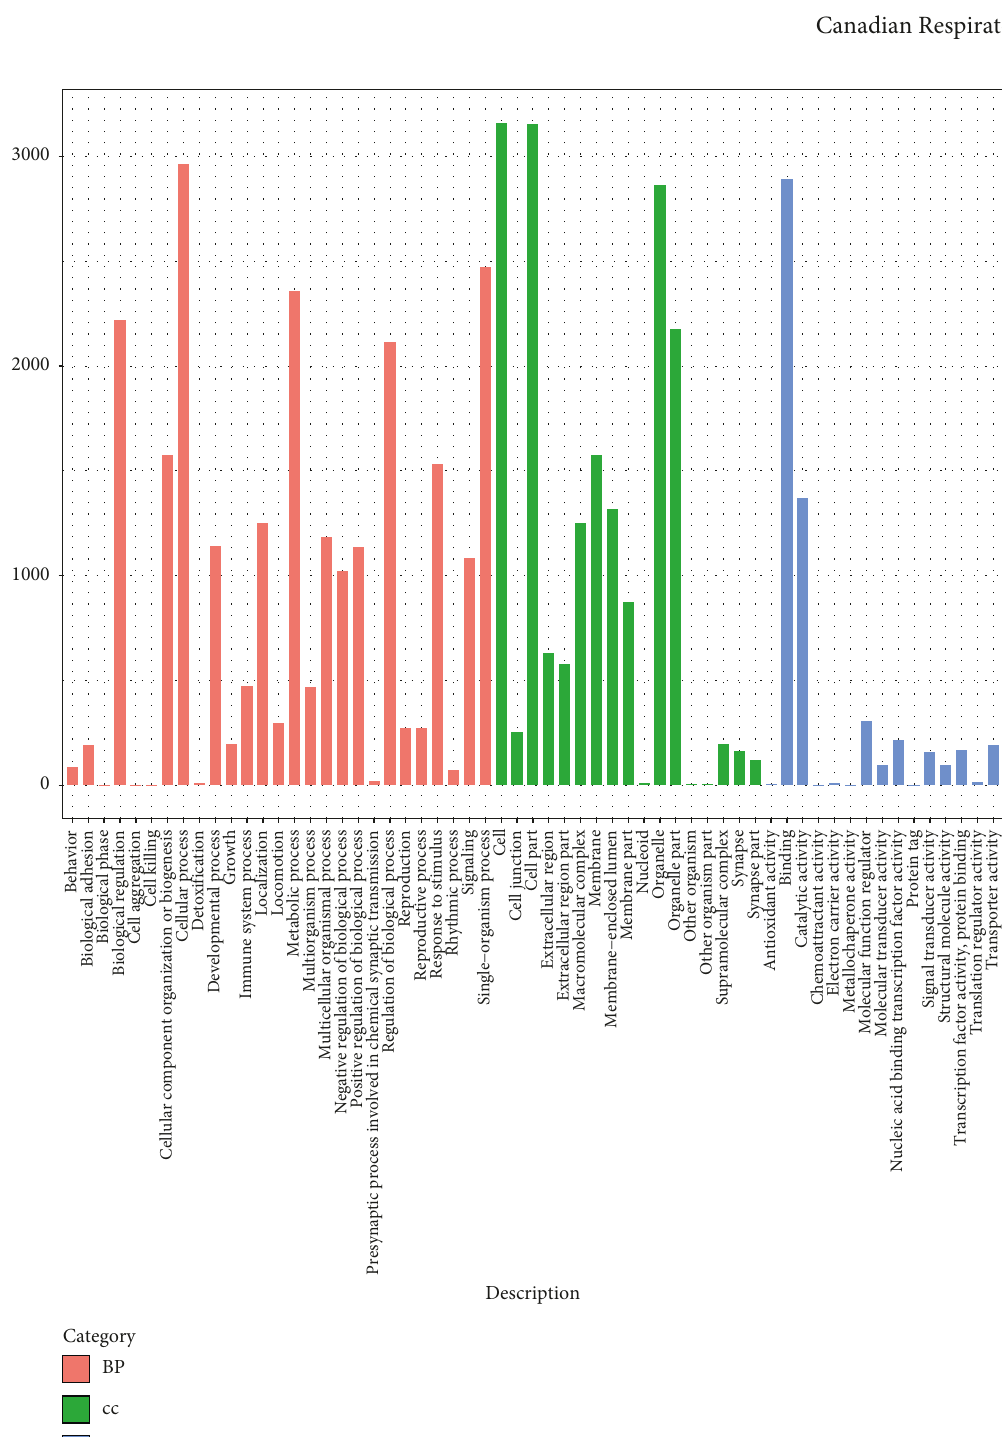
Figure 1: The functional terms enriched for the hosting genes of the identified circular RNAs (circRNAs). BP, biological process; CC, cellular component; and MF, molecular